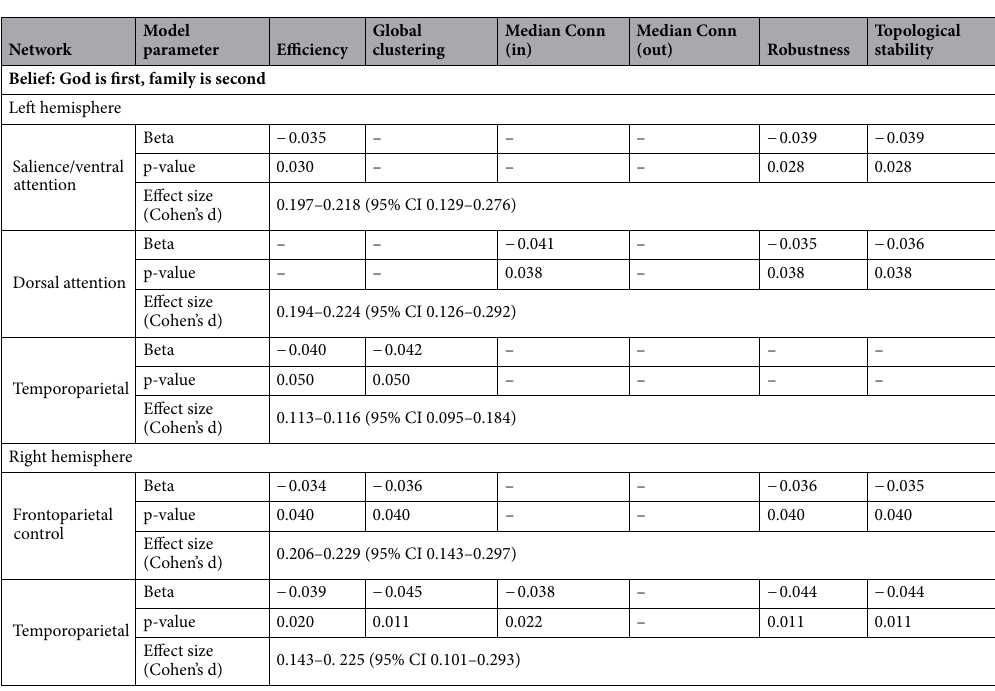
marized in Table 6. All networks impacted by religious beliefs are summarized in Table S1. In secondary analyses based on a set of structural equation models, the mediating effect of youth religiosity (the latent estimated vari- able) on the relationship between the strength of parental religious beliefs and network or node properties was nonsignificant (p ≥ 0.12). Individual regions (node‑specific properties). The strength of the belief that ‘ God is first, family is second ’ was associated with lower node centrality in the left salience/ventral attention (p < 0.05), right somatomotor (p = 0.03)